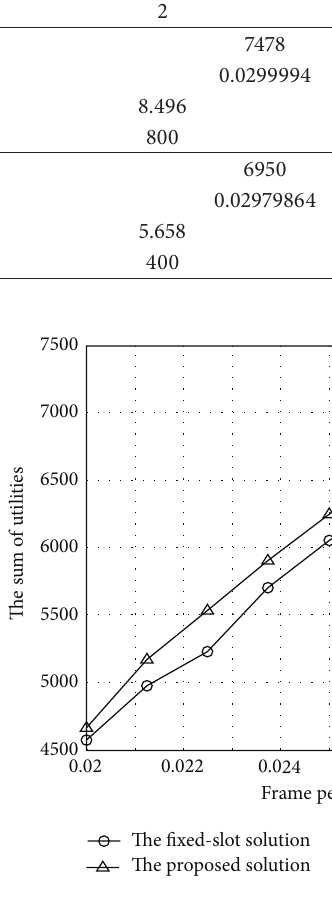
Figure 4: The sum of utilities with varying frame